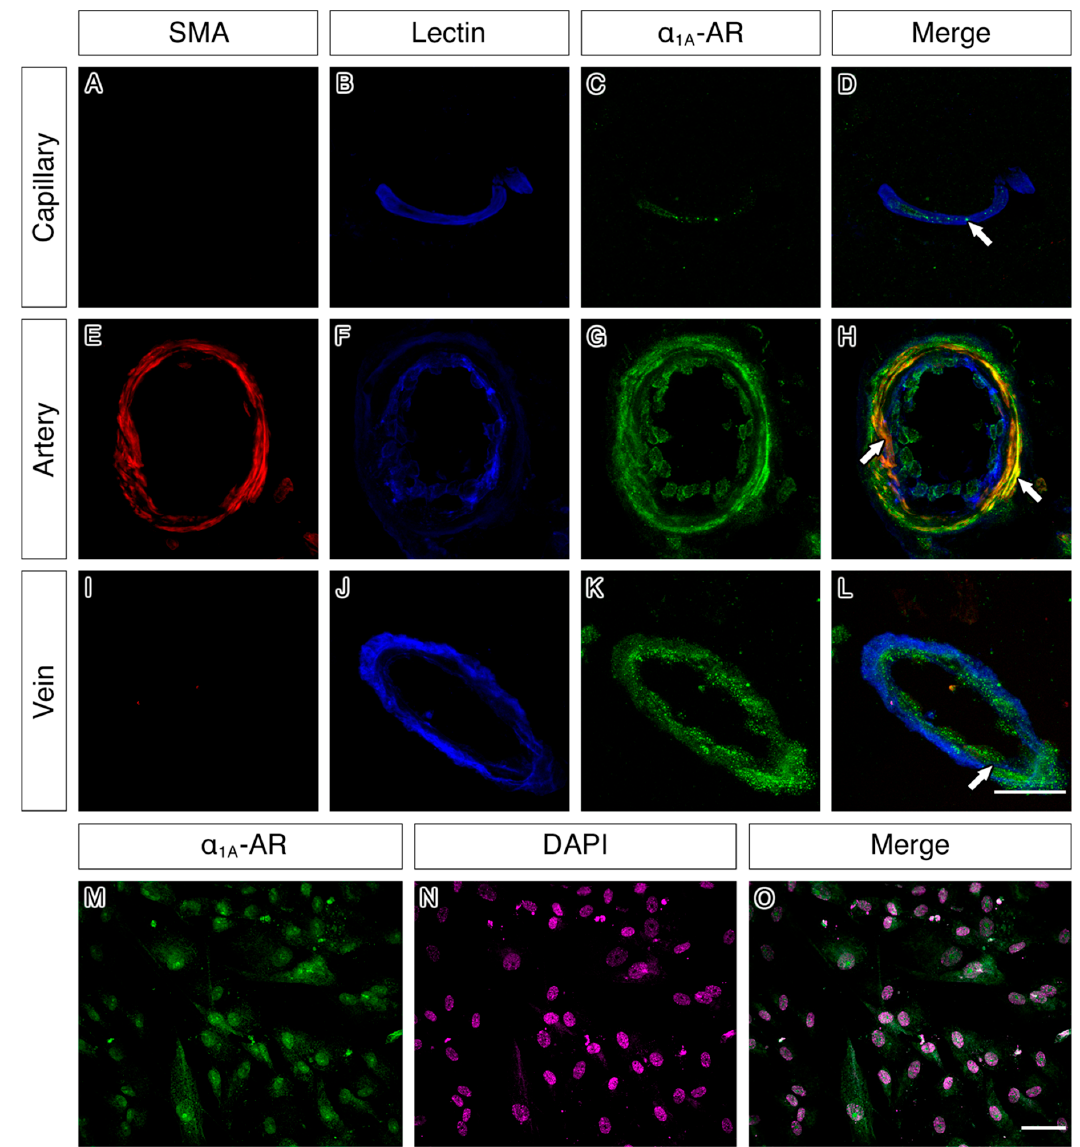
Figure 5. α 1A -AR immunoreactivity in the vessel walls of capillaries, arteries and veins and within cultured human brain vascular smooth muscle cells. α 1A -AR immunoreactivity ( green ) was observed colocalised ( white arrows ) to lectin ( blue ) in the vessel walls of capillaries ( A – D ), arteries ( E – H ) and veins ( I – L ) in all cases. α 1A -AR immunoreactivity was also colocalised with smooth muscle actin ( red ) in arterial walls ( H ) and observed to outline smooth muscle cell bodies in culture ( M – O ). Scale bar 50 µ